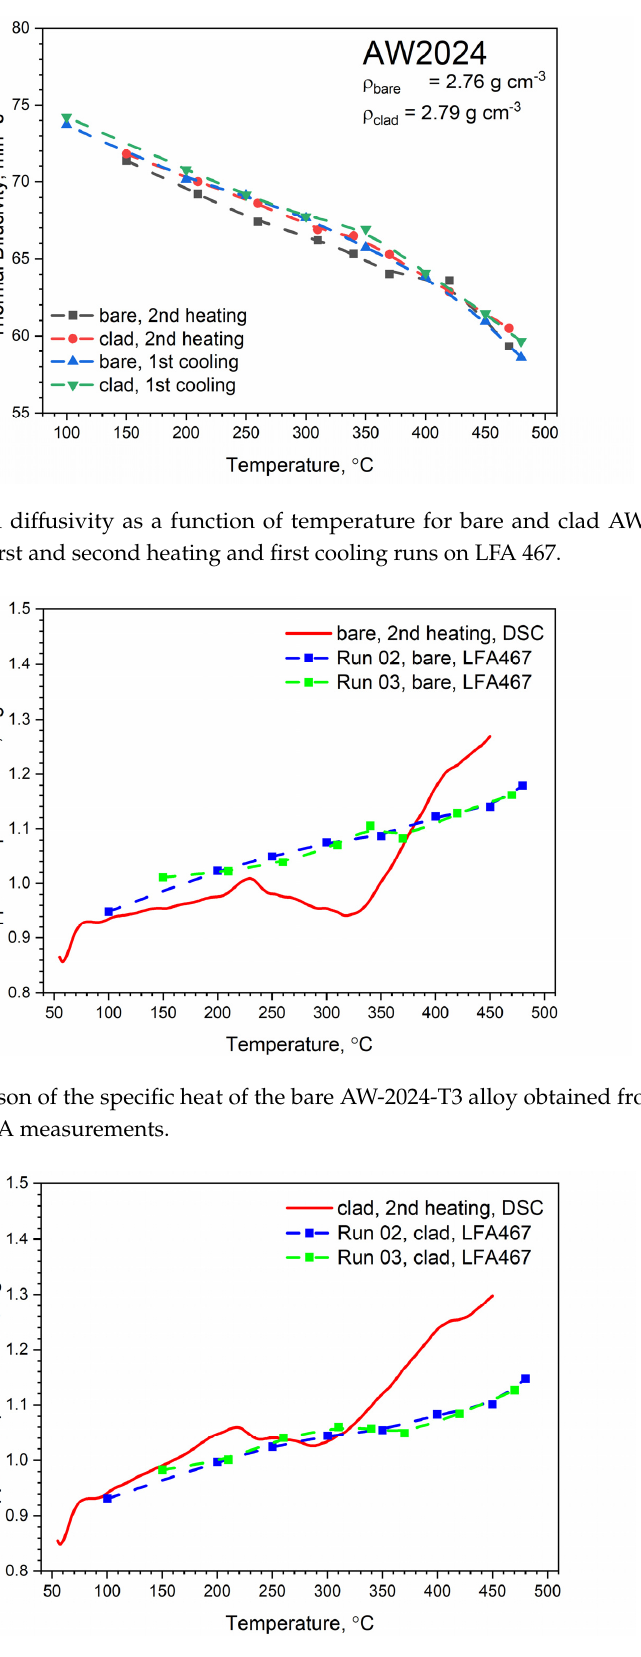
Figure 15. Comparison of the thermal conductivity of bare and clad AW-2024-T3 obtained from LFA measurements. The specific heat and thermal conductivity as a function of temperature for bare and clad AW- 2024-T3 alloys had a fixed density at RT, i.e., 2.76 g ⋅ cm − 3 for bare alloy and 2.79 g ⋅ cm − 3 for clad alloy, as was determined by the comparative method. The temperature characteristics of the apparent specific heat of both alloys obtained by the DSC method and the LFA comparative method for the second heating were similar. The differences in the apparent specific heat (cid:1855) (cid:3043) shown in Figures 13 and 14 were due to the relatively low sensitivity of the LFA comparative method. The thermal conductivity k shown in Figure 15 was calculated using the LFA comparative method as a product of the density, thermal diffusivity, and apparent specific heat to obtain data necessary for calculating heat transfer problems. 3.5. DMA Investigation The results of the loss modulus E ’’ test as a function of the temperature for the first and second heating runs are presented in Figure 16. The tests were carried out in the temperature range from RT to 400 °C . Similar to DSC, a qualitative difference between the first and second runs was found. In